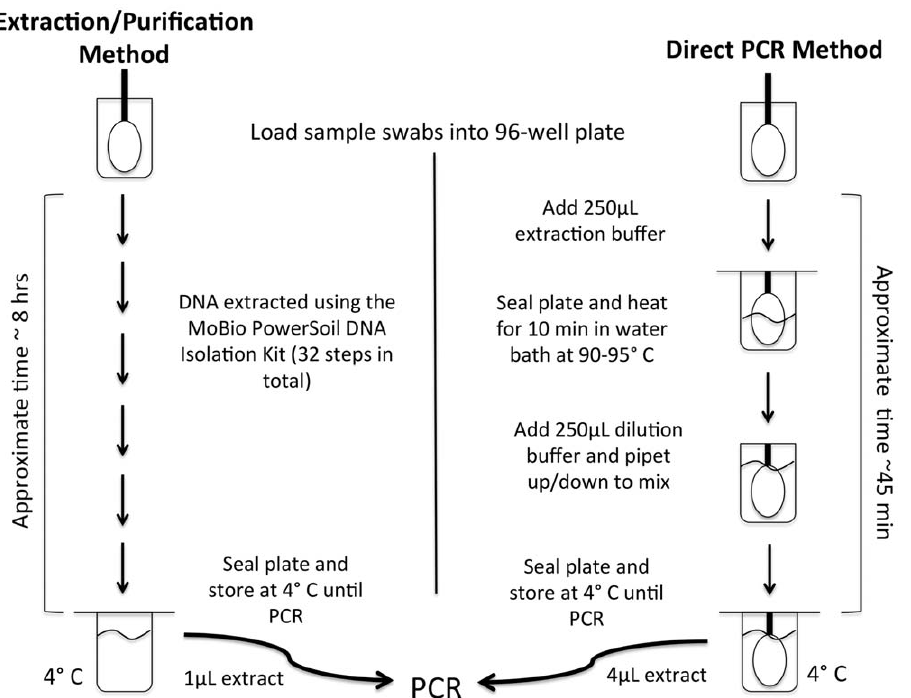
Figure 1. A diagram comparing the workflows used for the standard DNA extraction/purification approach and the direct PCR approach. The diagram illustrates the workflow used for the mouth and skin samples (the fecal samples were processed in a slightly different manner). See the Methods text for more detailed descriptions of these two approaches.